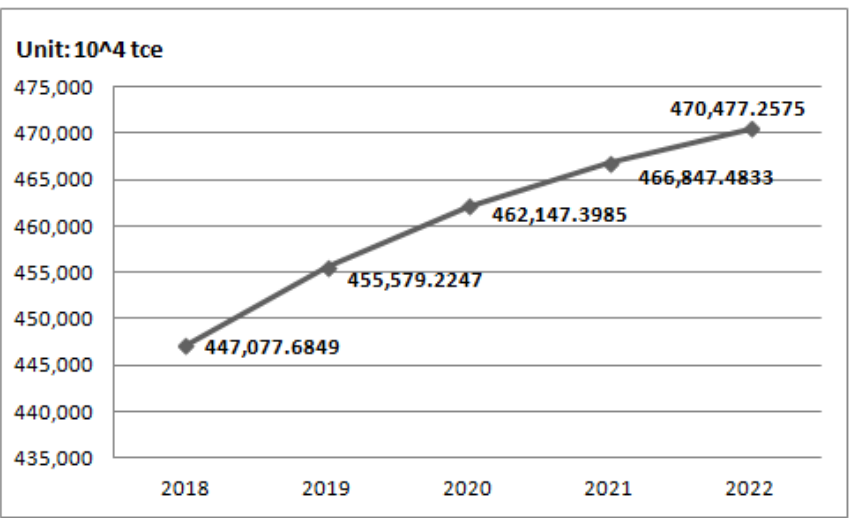
Figure 11. The forecasting results of energy consumption from 2018 to 2022 in China.